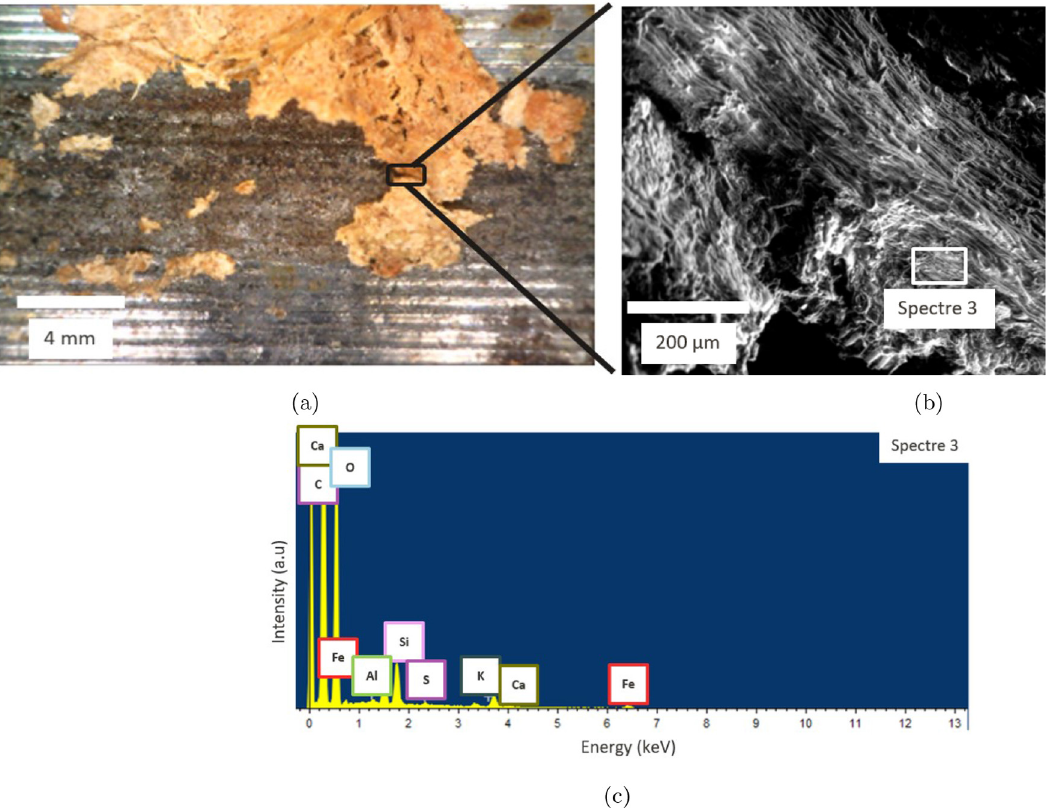
Fig. 7. (a) Macroscopic image of a laboratory-reproduced third body taken after a test (RH: 85%, Slip rate: 1%) on the Triboring tribometer. (b) SEM image of the sample (BSE detector), (c) EDS spectrum of the sample (b). The elements found correspond to plant residues and are similar to the one found in Figure